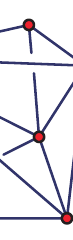
Figure 2. A globally rigid